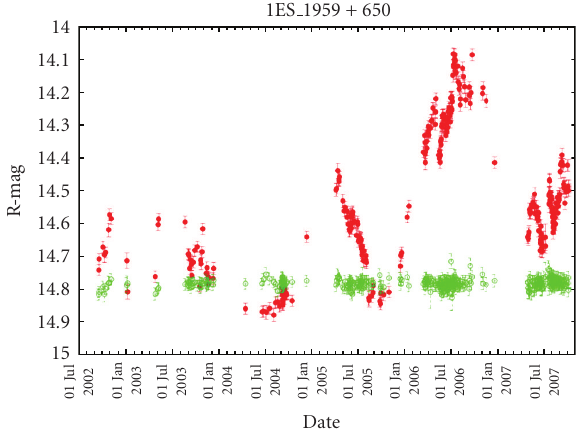
Figure 7: Optical light curve of blazar 1ES 1959+650 (in red, Tuorla Observatory blazar monitoring program). The green symbols represent the control measurement of constant star.